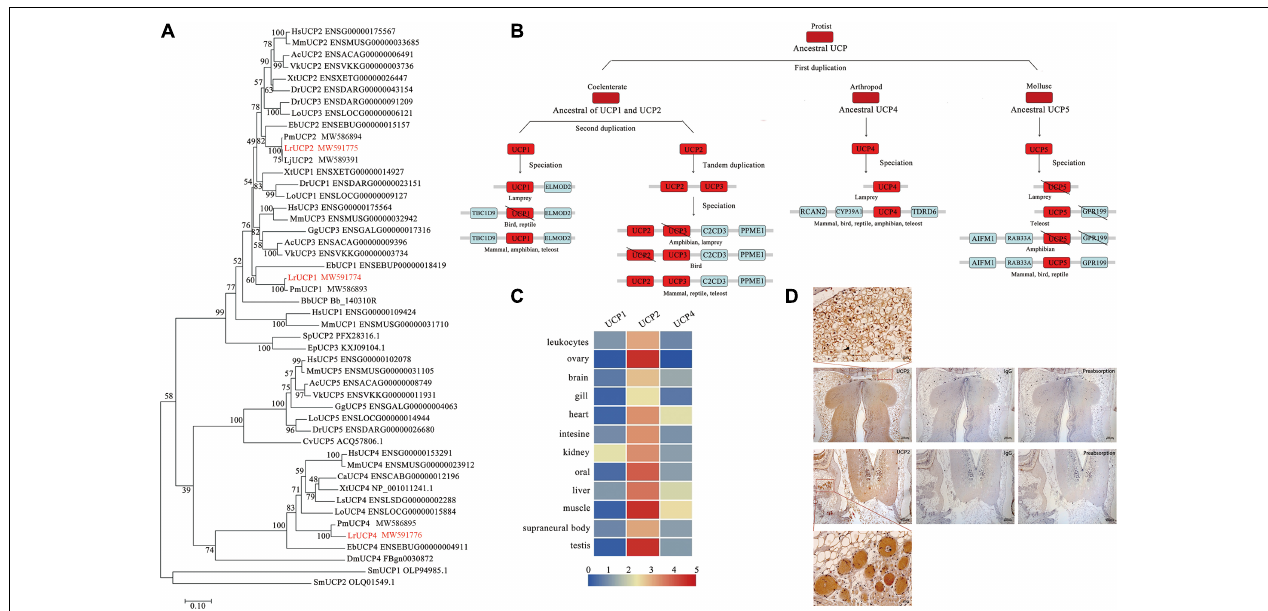
FIGURE 4 | Phylogenetic analysis and expression profiling of UCPs in lampreys. (A) Phylogenetic tree of the UCP family based on the NJ method. The numbers on interior branches indicate the bootstrap values derived from 1000 replications. All the amino acid sequence data used are from the Ensemble database and NCBI database. Hs, Homo sapiens ; Mm, Mus musculus ; Gg, Gallus gallus ; Ls, Lonchura striata ; Ac, Anolis carolinensis ; Vk, Varanus komodoensis ; Ca, Chelonoidis abingdonii ; Xt, Xenopus tropicalis ; Dr, Danio rerio ; Lo, Lepisosteus oculatus ; Eb, Eptatretus burgeri ; Lr, Lethenteron reissneri ; Bb, Branchiostoma belcheri ; Dm, Drosophila melanogaster ; Cv, Crassostrea virginica ; Ml, Macrostomum lignano ; Sm, Symbiodinium microadriaticum . (B) Evolutionary scenario of the UCP gene in vertebrates. The major evolutionary events are highlighted. The \ symbol indicates genes that have been lost. (C) Expression of UCPs in different tissues of Reissner lampreys. (D) Immunohistochemistry of LrUCP2 in brown adipocytes in lamprey